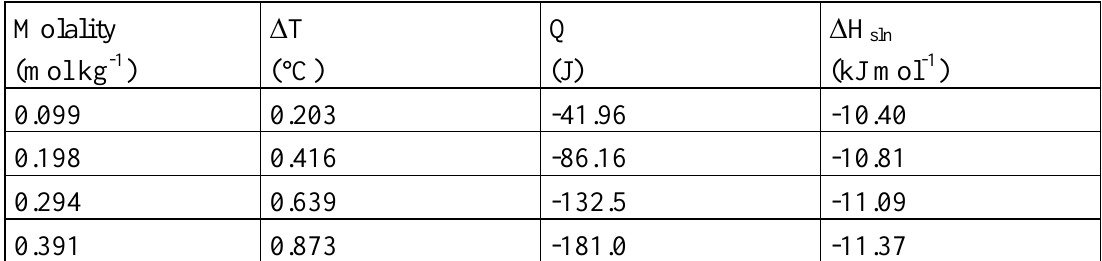
Table 2. Determination of the Enthalpy of Solution of Propanol in Water at 25 °C.